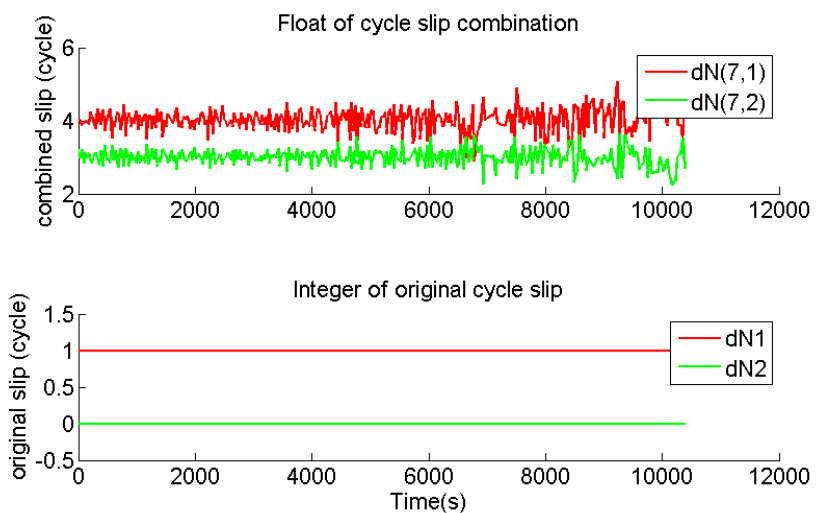
Figure 15. Results of the cycle-slip combinations and original cycle slip supplied by the BDCSR methodology from MEO Satellite 11 in a weak condition of low elevations during the geomagnetic storm, where the known cycle slips of (1,0) were inserted epoch-by-epoch in the phase data collected at the CUT0 station started from UTC 8 May 2016 00:00:00 with an interval of 30 s.